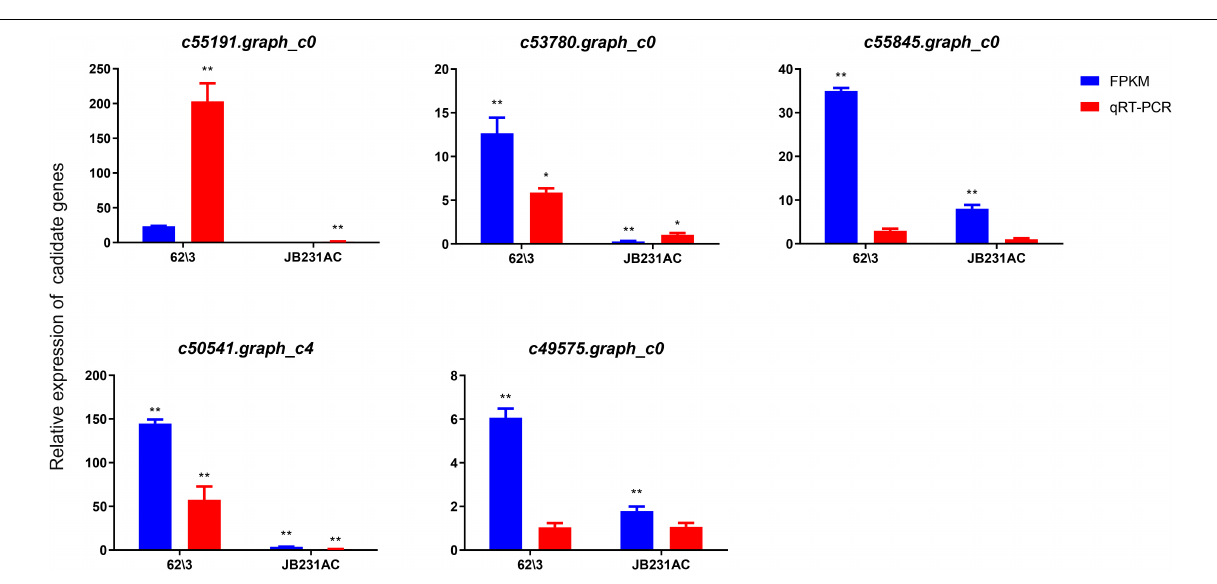
FIGURE 8 | RNA-Seq and qRT-PCR were used to compare DEGs in 62\3 and JB231AC. The relative gene expression level was calculated by 2 − (cid:49)(cid:49) CT in qRT-PCR. * P < 0.05, ** P <